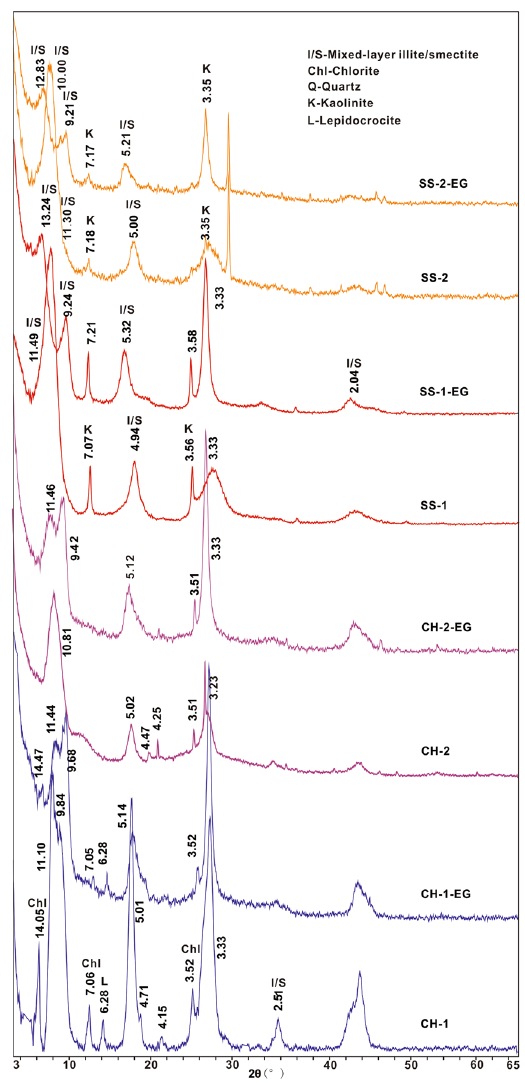
Figure 5. Experimental and calculated XRD patterns of the oriented, air-dry specimens from studied clay mineral samples ((a) CH-1, (b) CH-2, (c) SS-1, (d) SS-2).